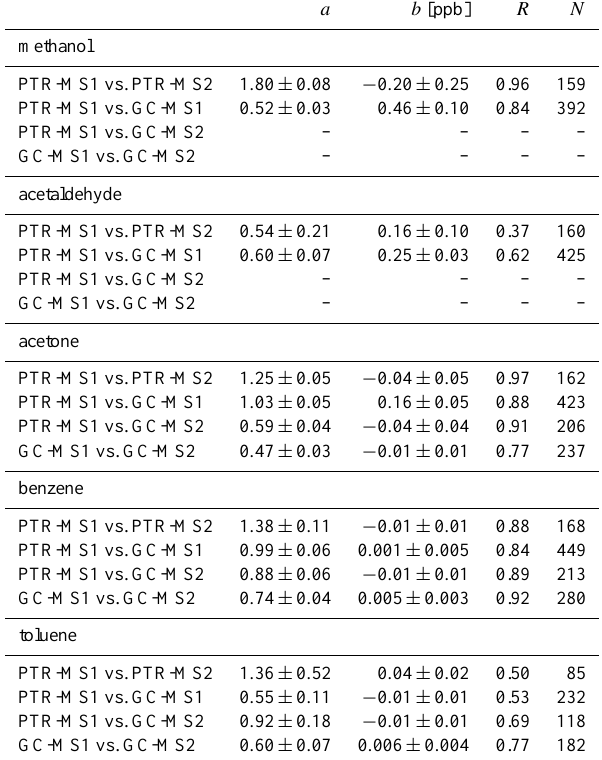
Table 3. Statistical parameters of the correlation analysis for the measured compounds. N is the number of data points considered in the correlation analysis and R the correlation between two instru- ments for each compound. Parameters a and b are the slope and the offset of a linear fit, respectively.